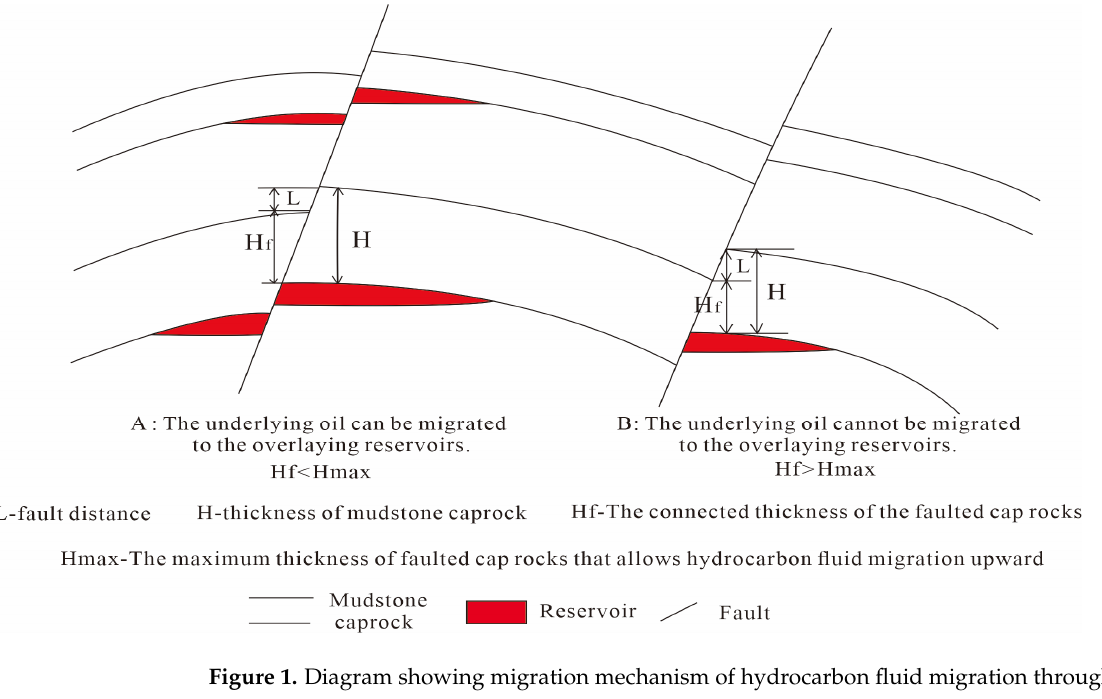
Figure 1. Diagram showing migration mechanism of hydrocarbon fluid migration through faulted cap rocks.